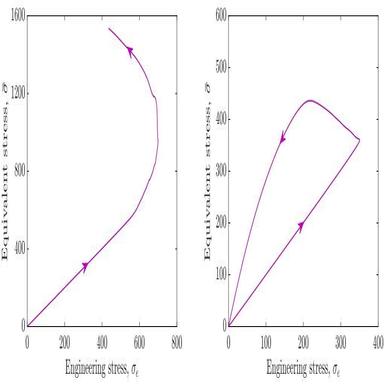
Necking effect correction curves: strain correction (ε¯ - εe) and stress correction (σ¯ - σe).